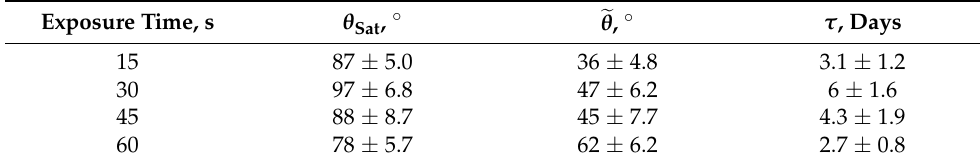
Table 3. Parameters of the exponential fitting of the kinetics of hydrophobic recovery following the radiofrequency plasma treatment of PVC. Table 2. Parameters of the exponential fitting of the kinetics of hydrophobic recovery following the Corona plasma treatment of PVC.